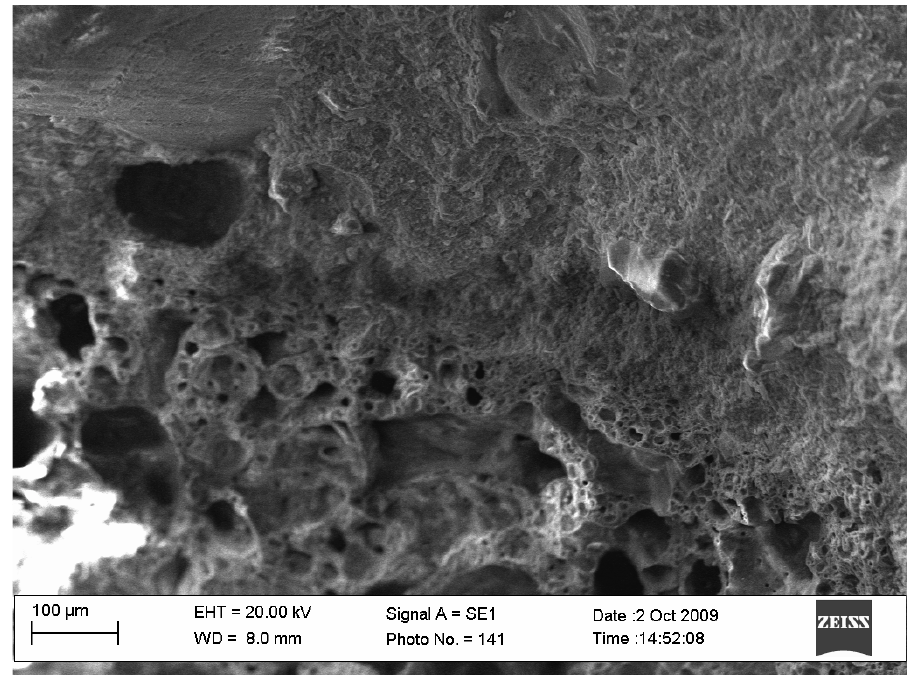
Figure 3. Ceramzite sand and pore microstructure.